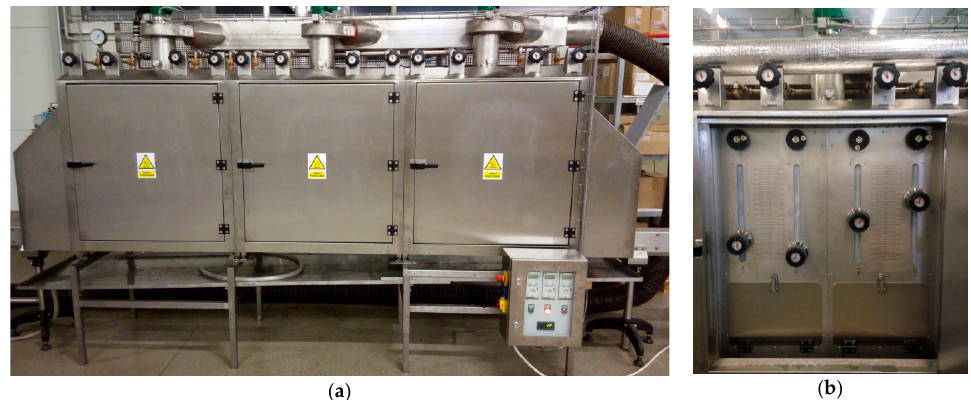
Figure 8. Photographs of: ( a ) the shrink tunnel in which the test was carried out; ( b ) the control panel of the steam flow rate in a sample section of the tunnel.